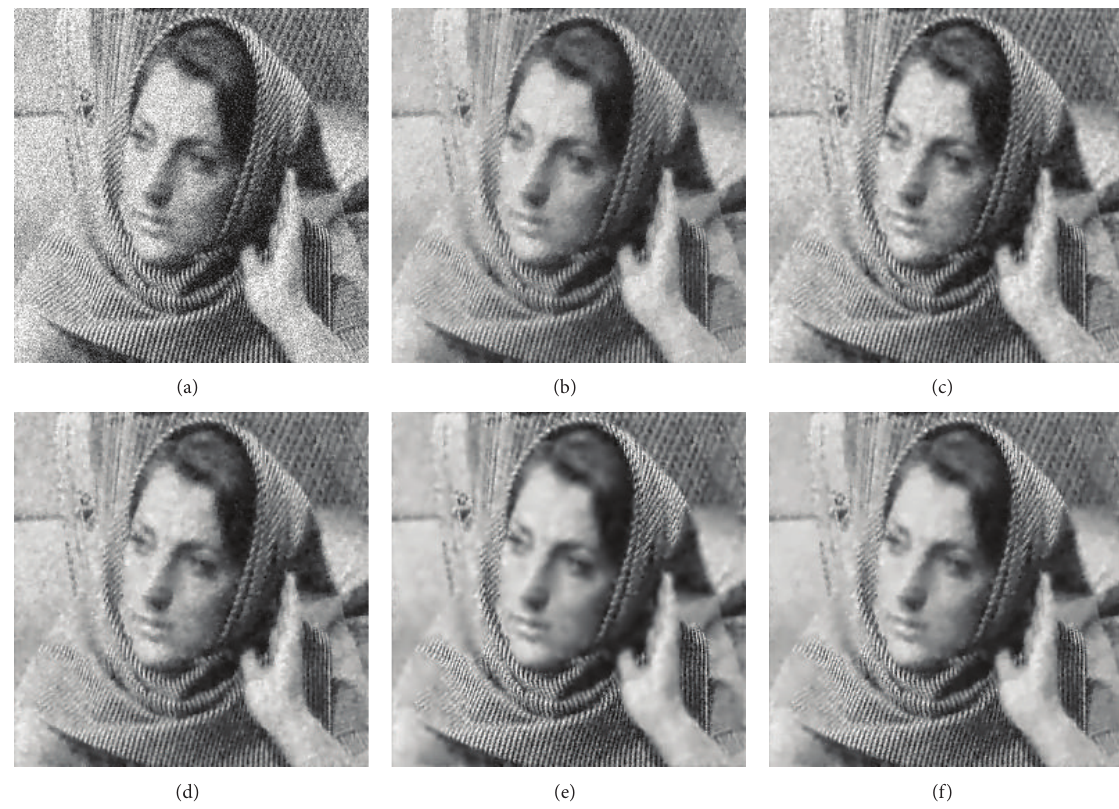
Figure 6: Results of different models for the image “Barbara”: (a) the noisy image, the restored images by (b) the ROF model, (c) the LLT model, (d) the hybrid model, (e) our Model 1 ( 𝛼 = 0.28 and 𝑟 = 7 ), and (f) Model 2 ( 𝛼 = 0.39 and 𝑟 = 7